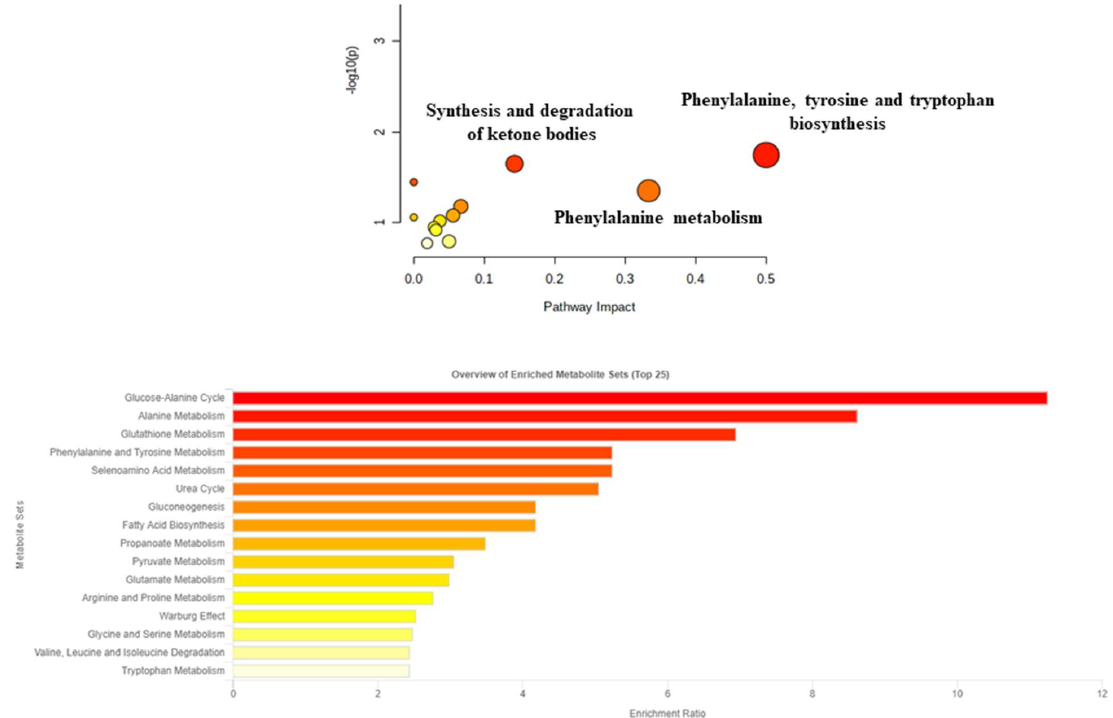
Figure 3. Metabolic pathways built using only metabolites with a VIP value higher than 1.